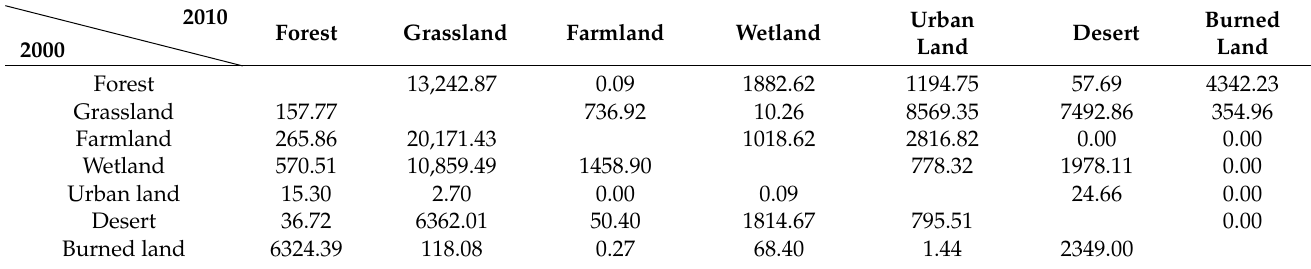
Table 3. Land cover transition matrix from 2000 to 2010 (hm 2